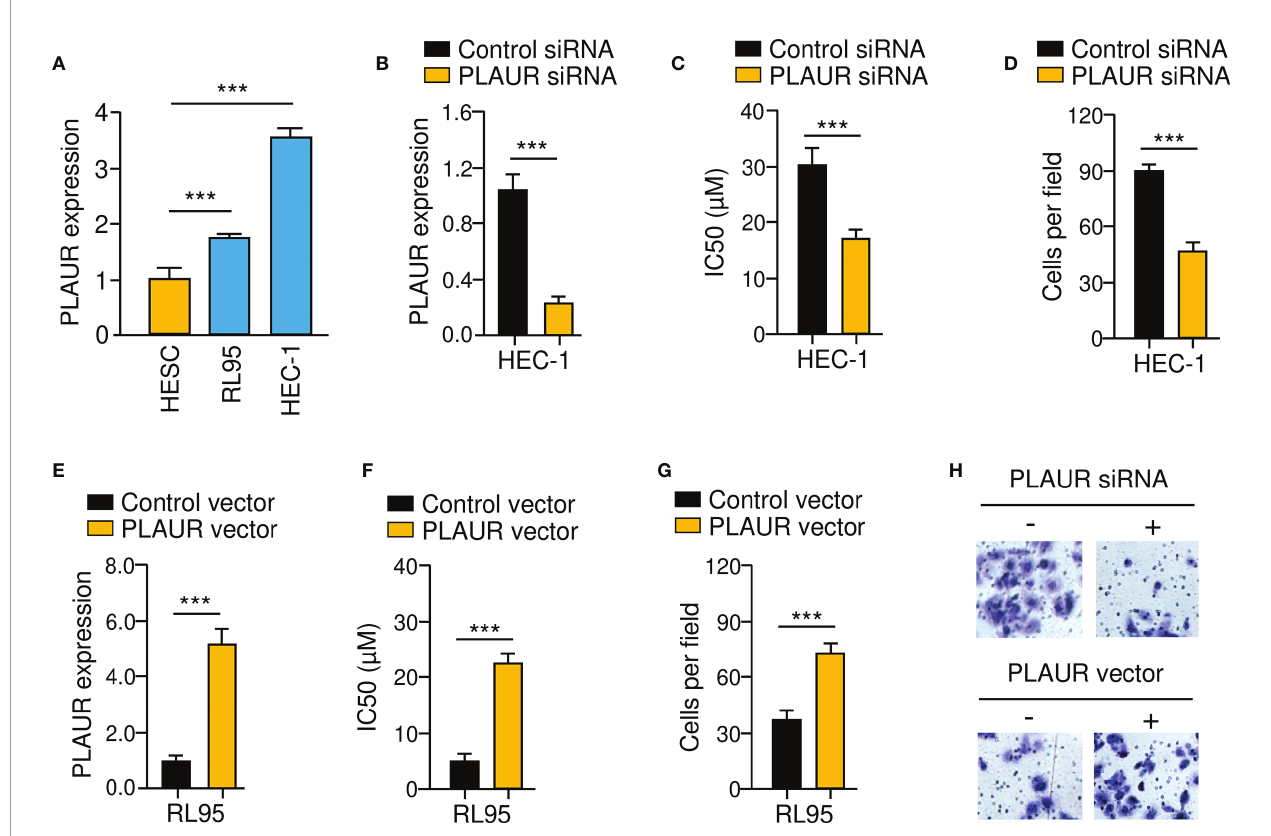
FIGURE 10 | PLAUR Silencing Reduces Paclitaxel Resistance and EC Cell Invasion. (A) PLAUR mRNA levels in EC cells and HESC cells. (B) Expression of PLAUR in HEC-1 cells transfected with PLAUR siRNA or control siRNA. (C) Paclitaxel cytotoxicity in HEC-1 cells transfected with PLAUR siRNA or control siRNA. (D) The invasion of HEC-1 cells transfected with PLAUR siRNA or control siRNA was measured using cell invasion assays. (E) Expression of PLAUR in RL95 cells transfected with PLAUR expression vector or control vector. (F) Paclitaxel cytotoxicity in RL95 cells transfected with PLAUR expression vector or control vector. (G) The invasion of RL95 cells transfected with PLAUR expression vector or control vector was measured using cell invasion assays. (H) Representative images of cell invasion assays. *** P <